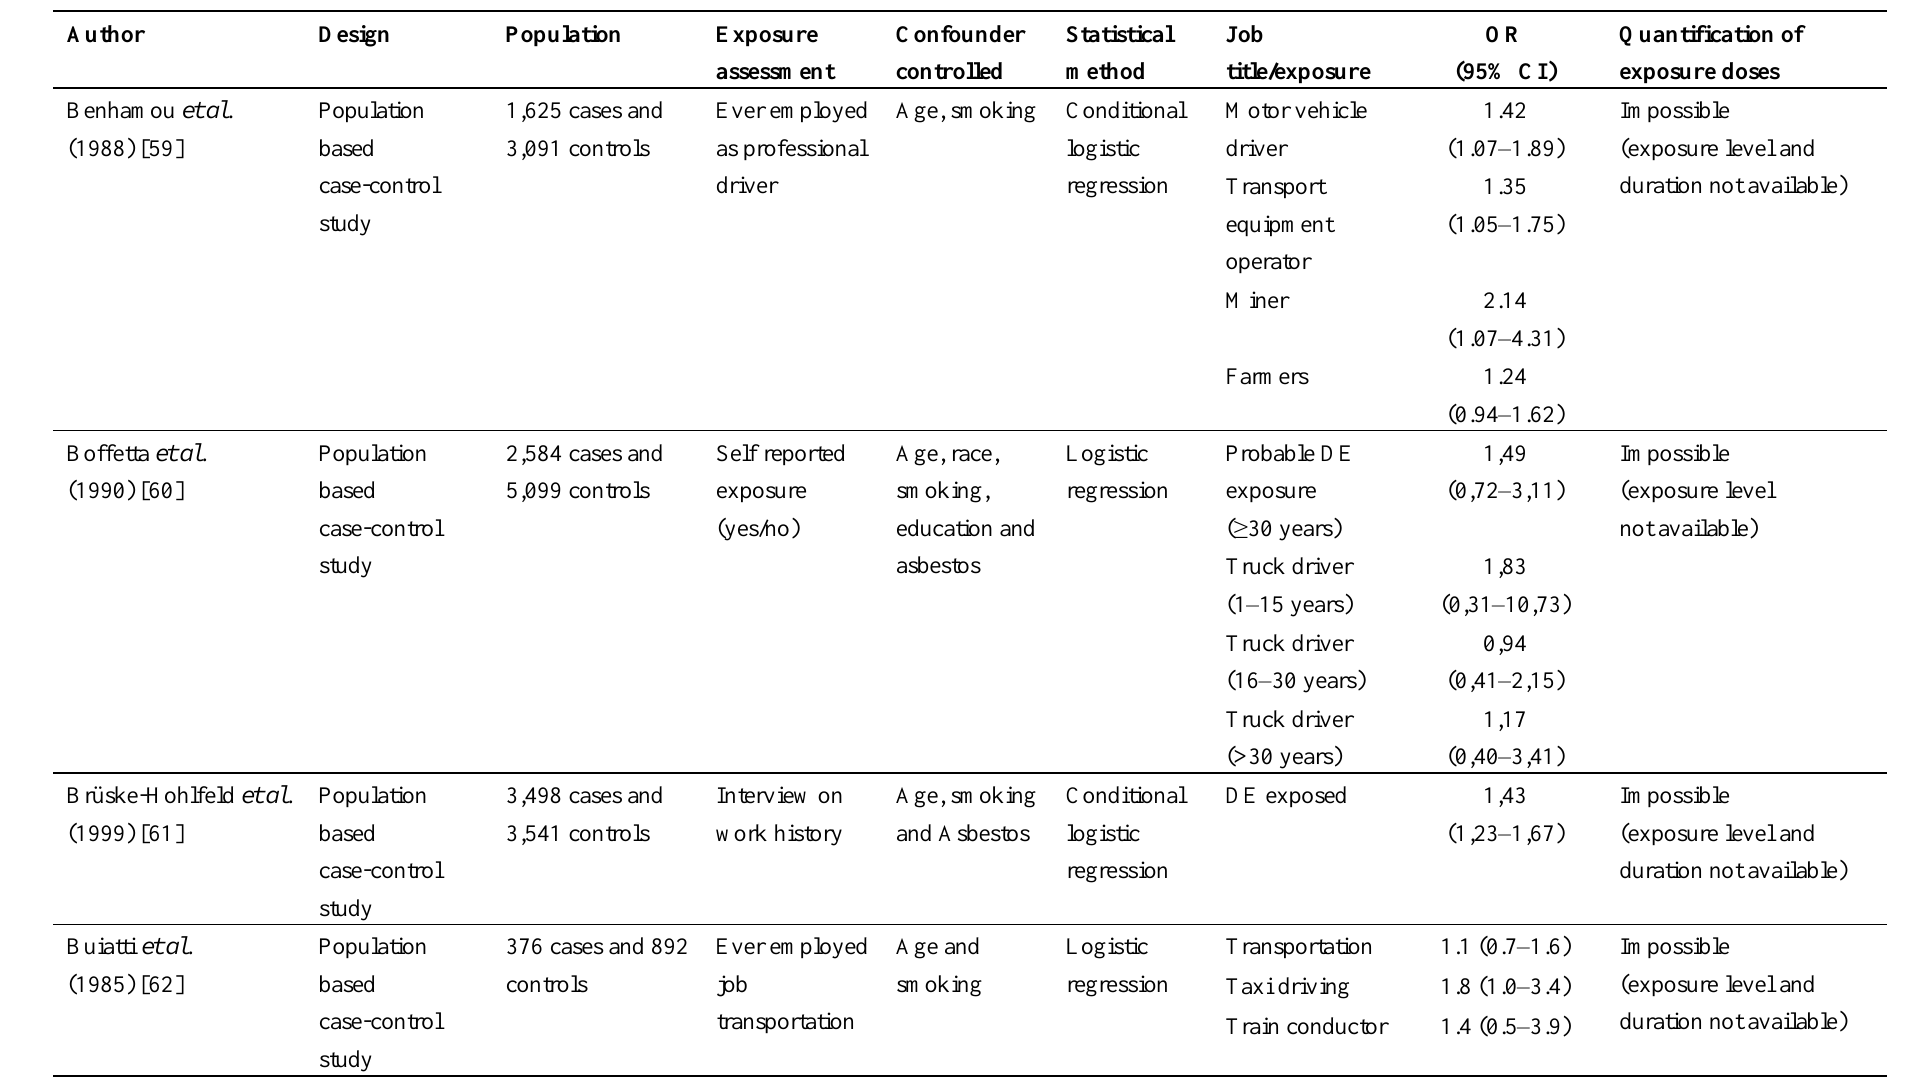
Table 3. Case-control studies on diesel exhaust exposure and lung